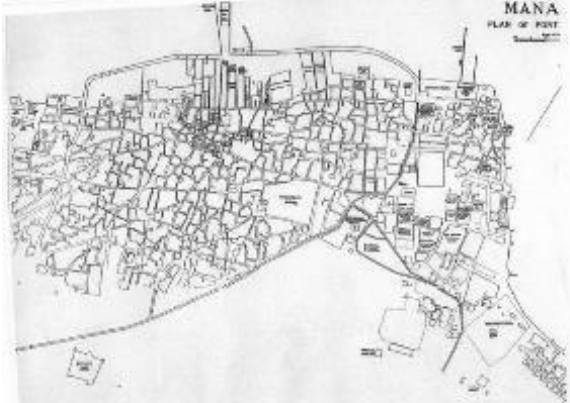
Figure 1. A map of Manama of the early ‘30s clearly show the morphological structure and the extent of the two fabrics at the beginning of the modernization process (Agriculture, 2007)